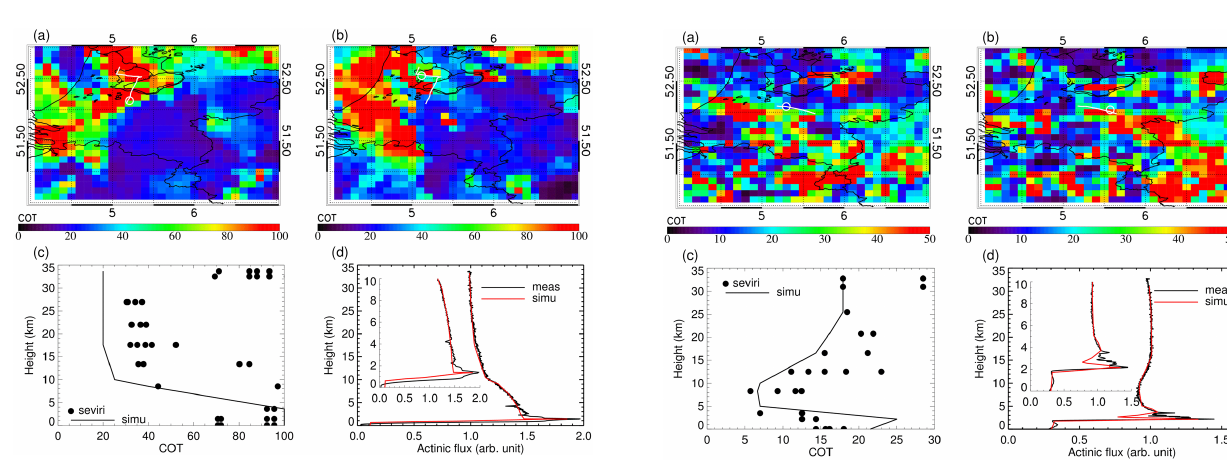
Figure 12. Same as Fig. 9 but for 10 August 2006.